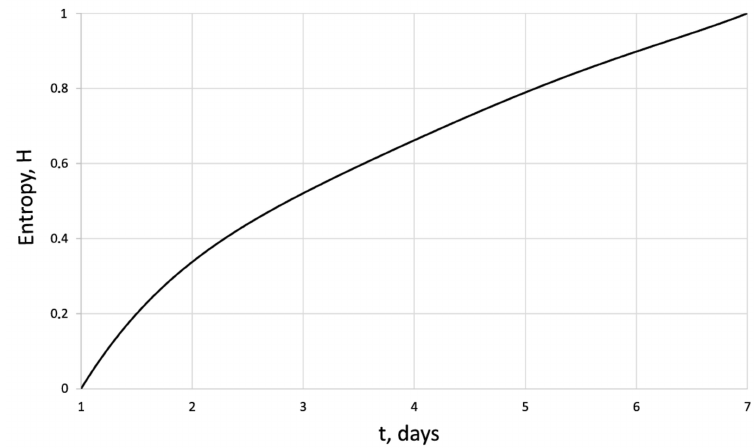
Figure 5. Entropy of the human dermal fibroblasts in control series.